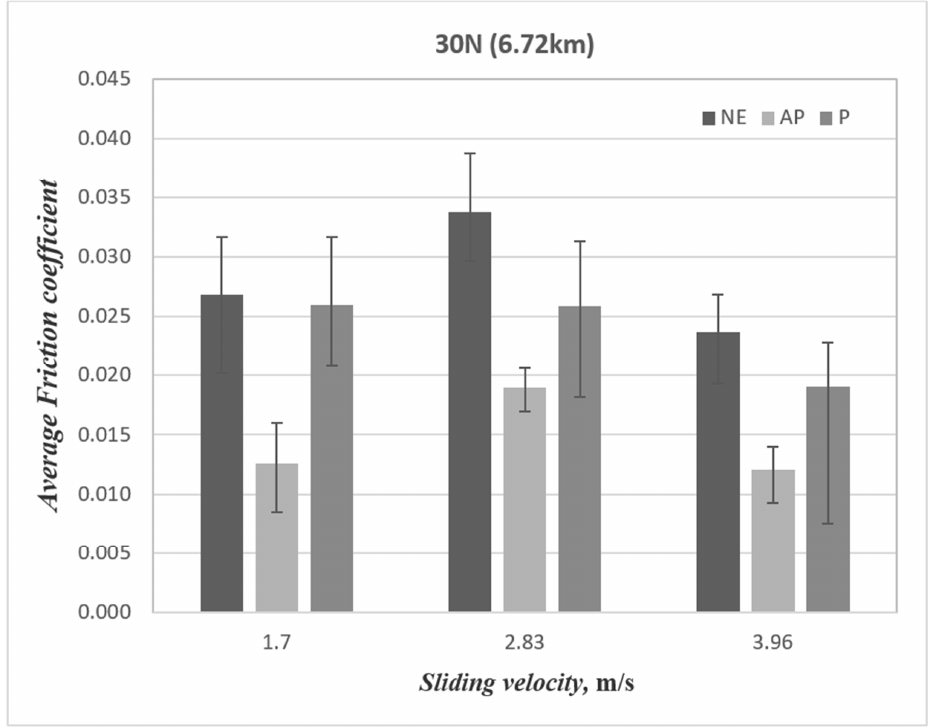
Figure 10. Friction coefficient vs. sliding velocity for different fibre orientation (AP and P) and neat epoxy subjected to 30 N of applied load at different of sliding